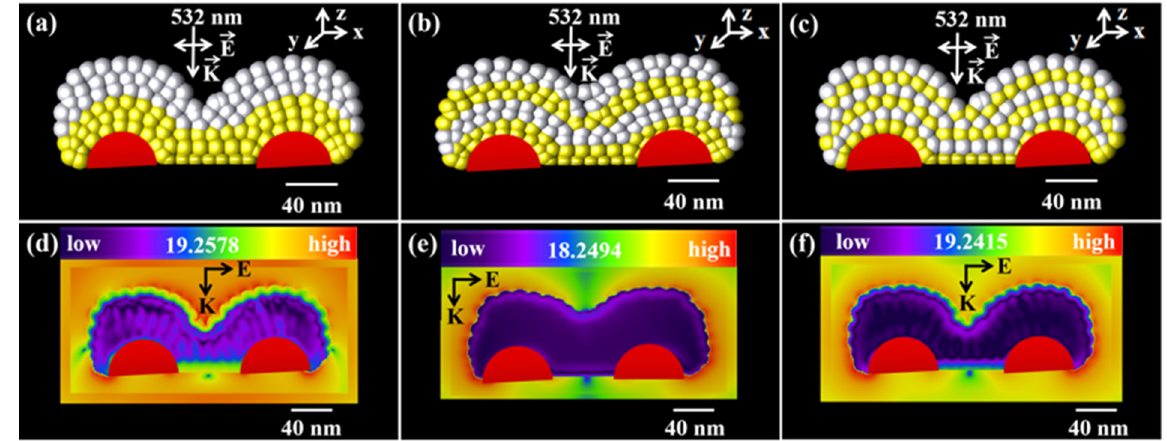
Figure 8. ( a – c ) Three ‐ dimensional FDTD models of Ag@Cu@MW substrates with different alternating sputtering layers. ( d – f ) The electric near ‐ field intensities maps for the x–z plane around the corresponding substrates in a – c .